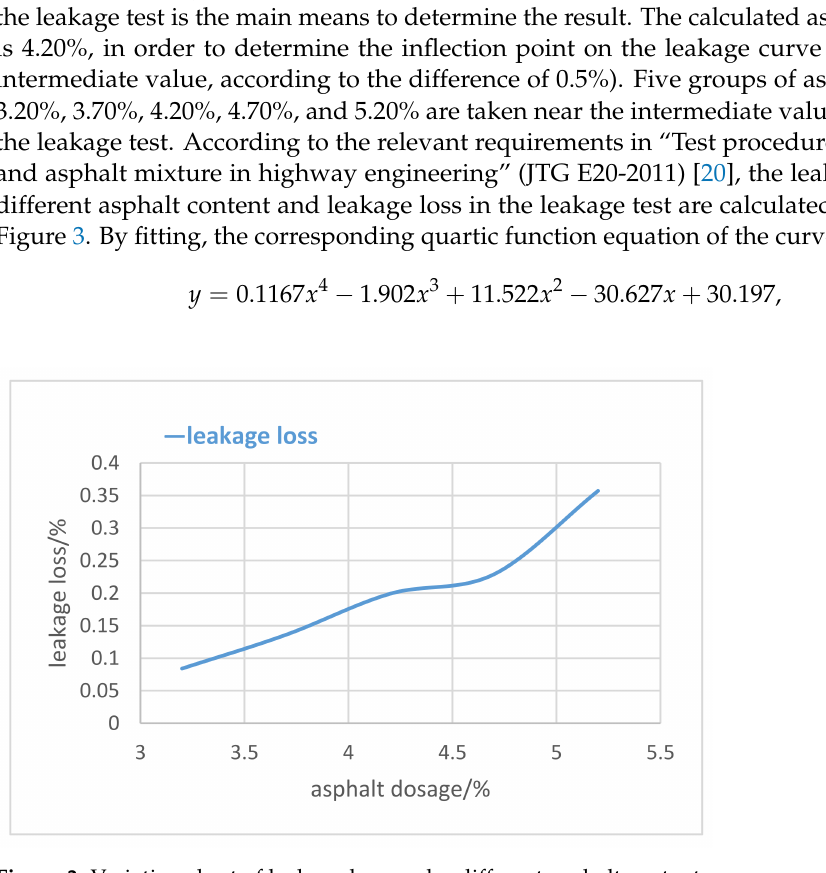
Figure 3. Variation chart of leakage loss under different asphalt